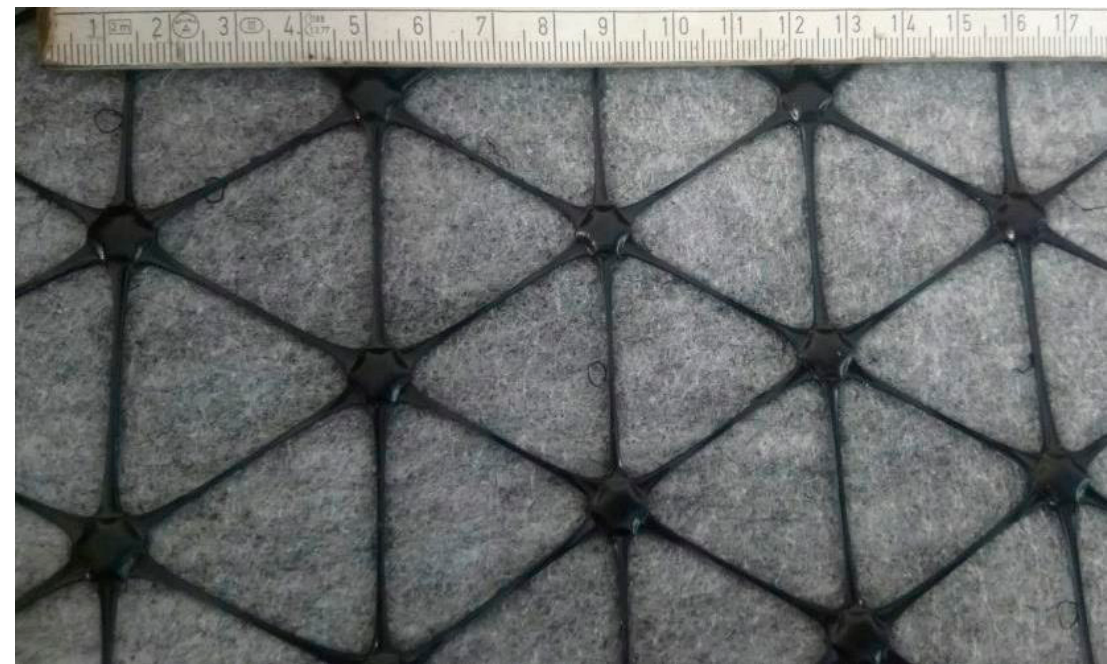
Figure 1. View of the AR-GN composite, square geogrid bonded to non-woven geotextile.